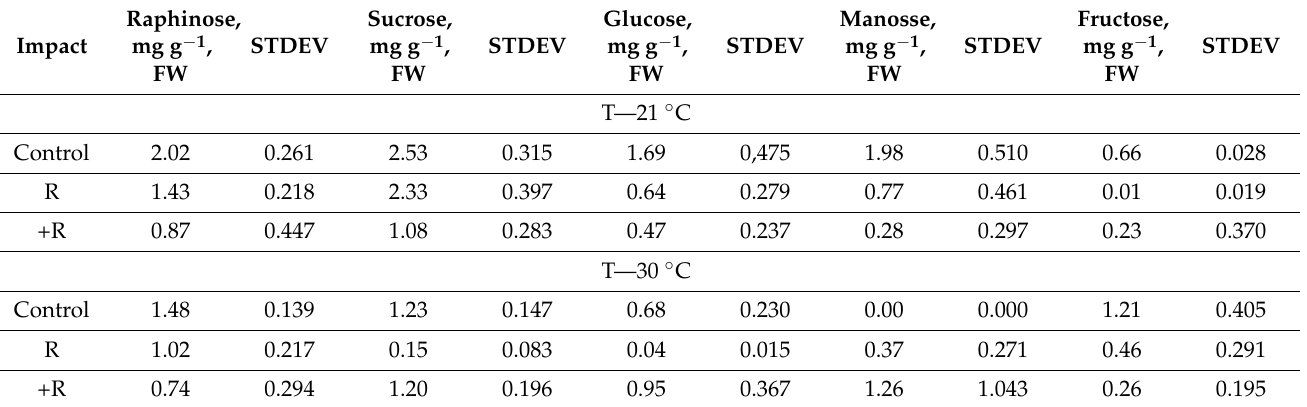
Table 3. Non-structural carbohydrates of tomato cultivated under combinations of different tempera- ture and HPM